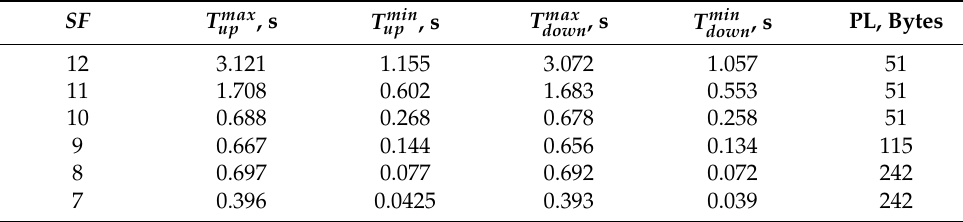
Table 2. Frame parameters in LoRaWAN.